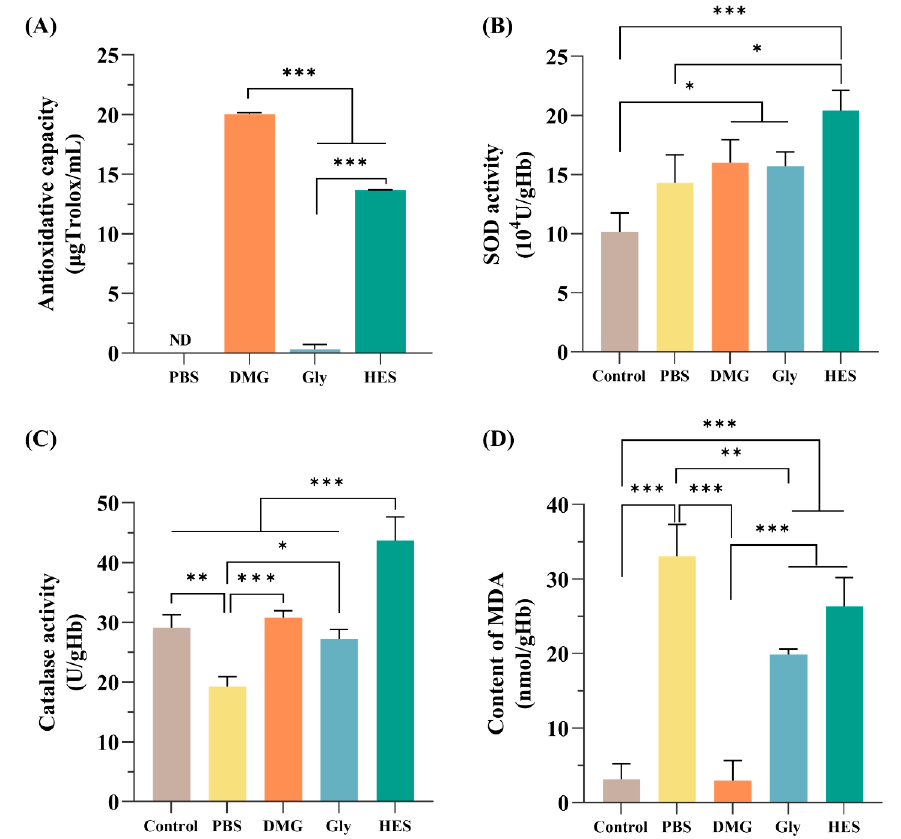
Figure 5. Ability to counter oxidative damage. ( A ) The antioxidant capacity was measured by the DPPH assay. The SOD ( B ) and CAT ( C ) activities of RBCs in different groups. ( D ) The content of MDA. The fresh RBCs without cryopreservation were selected as the control group. The concentrations of Gly, DMG, and HES were 20%, 4%, and 13%, respectively. Data are presented as the mean ± SD. * p < 0.05, ** p < 0.01, *** p < 0.001.